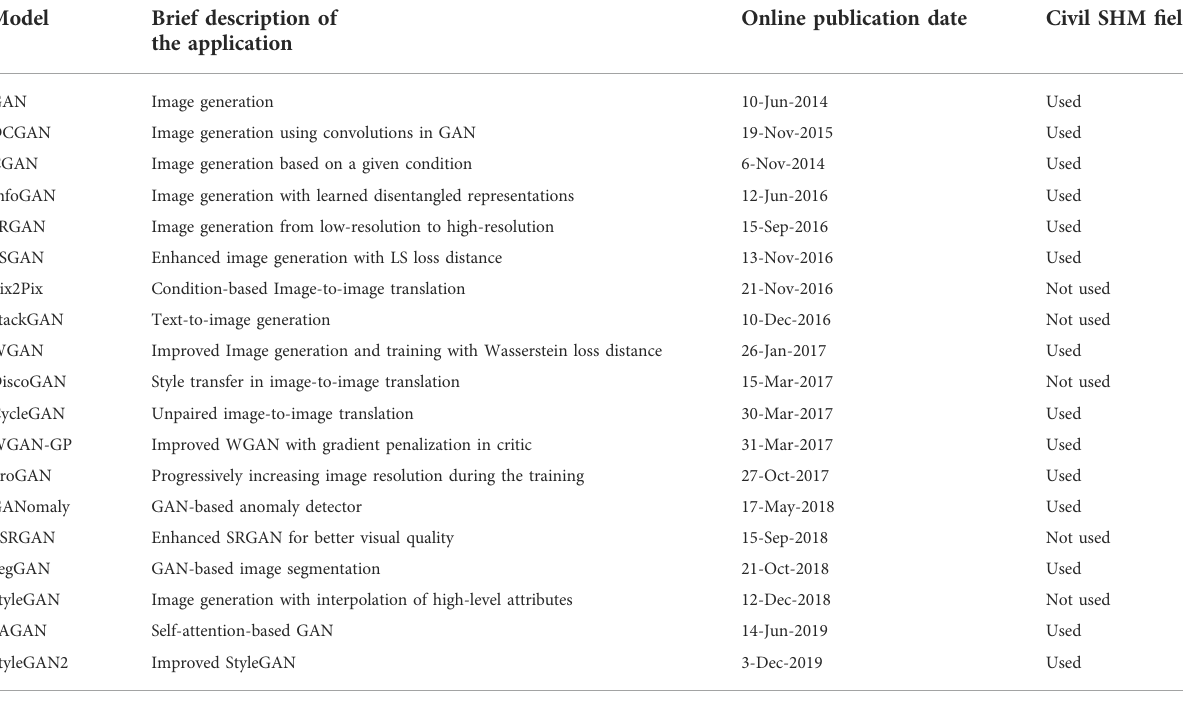
TABLE 1 Notable GAN models over the years and the ones employed in the civil SHM fi eld.